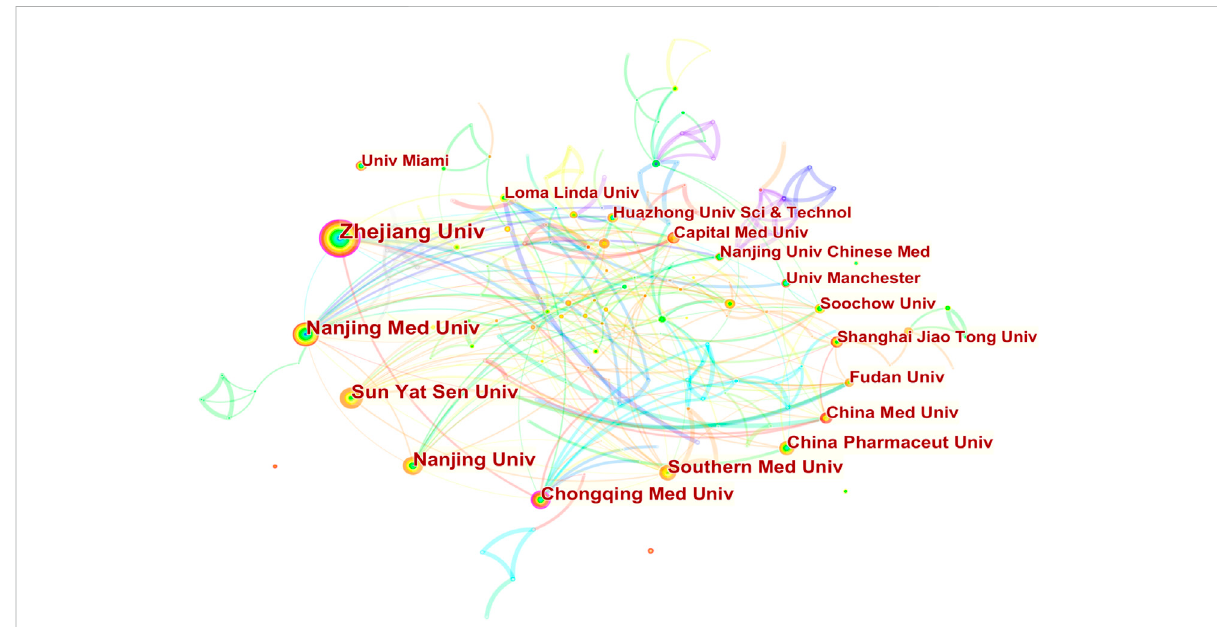
FIGURE 5 Publications over institutions. The node size represents the number of articles. The larger the node, the greater the number of articles. The highest number of publications is from Zhejiang University, followed by Nanjing Medical University, Sun Yat Sen University, Nanjing University, and Chongqing Medicine University. Other countries are shown in counterclockwise order in the picture. The lines between the nodes represent the cooperation between the different institutions.